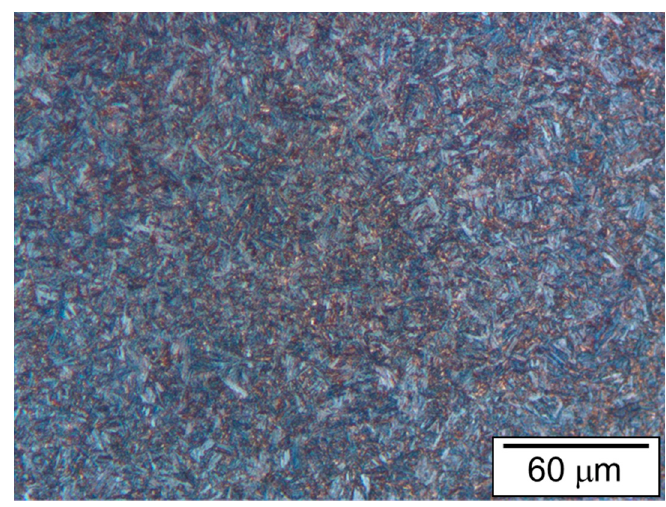
Figure 4. The Microstructure of the Austempered AISI 4140 Steel Alloy (Sodium Bisulfate etch).